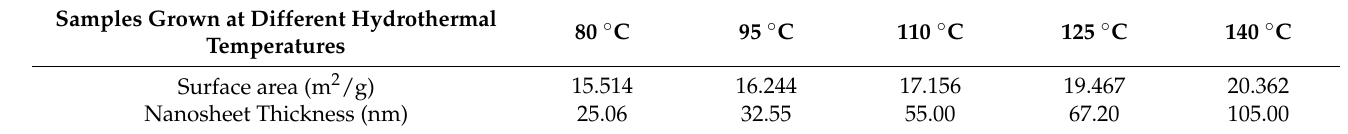
Table 1. Surface areas and thickness variations with different hydrothermal temperatures.